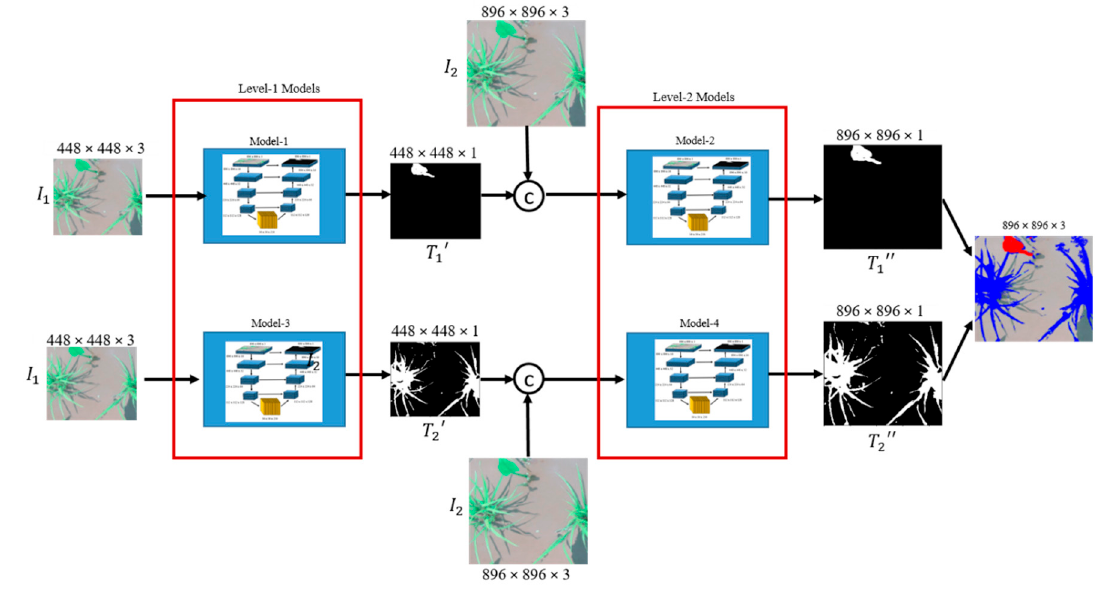
Figure 2. Architecture of the proposed cascaded encoder-decoder (CED-Net). All four models are trained independently. The target for Model-1 and Model-2 is weed while the target for Model-3 and Model-4 is the crop.